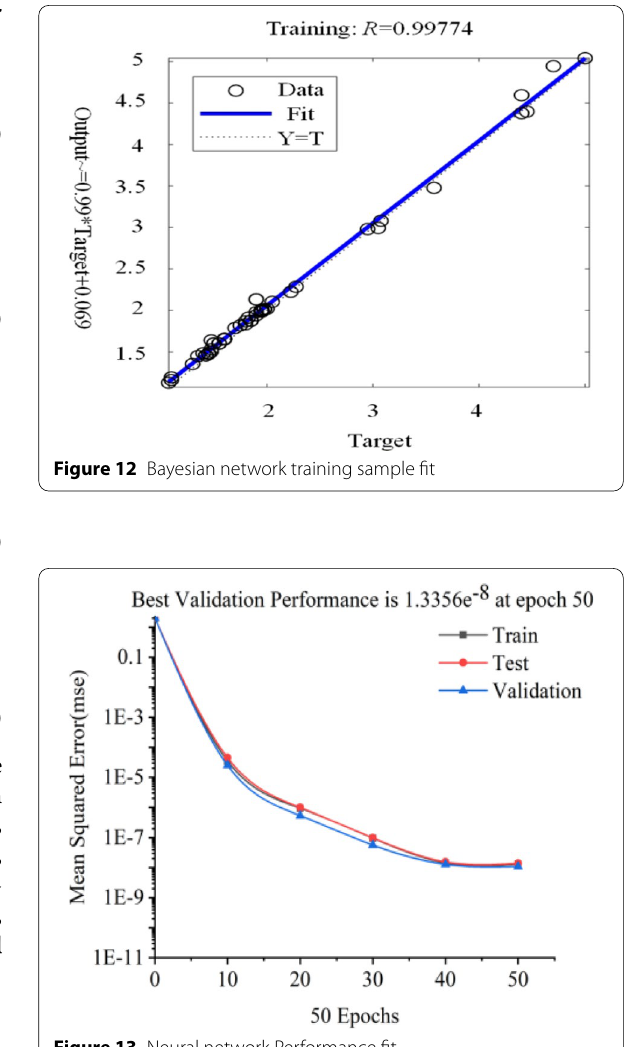
Figure 13 Neural network Performance